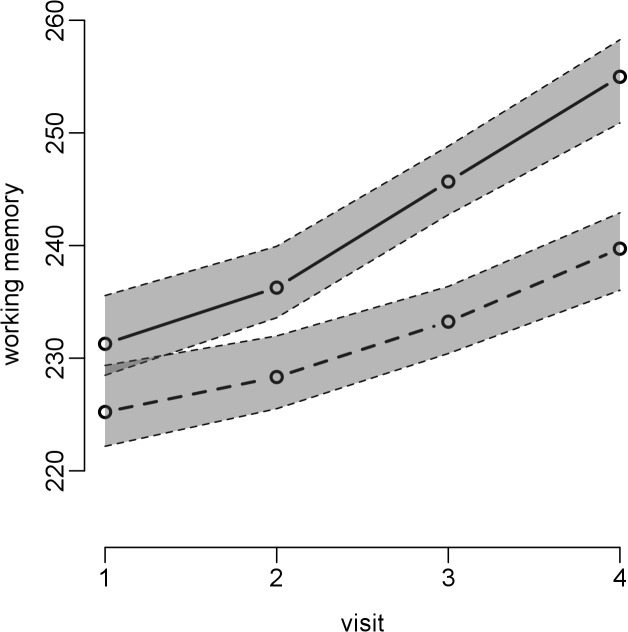
Working memory development by high- or low-traffic-air-pollution school.Dashed line = high traffic air pollution; continuous line = low traffic air pollution; gray shading indicates 95% CIs. Adjusted for age, sex, maternal education, residential neighborhood socioeconomic status, and air pollution exposure at home; school and individual as nested random effects in 2,715 children and 10,112 tests from 39 schools.